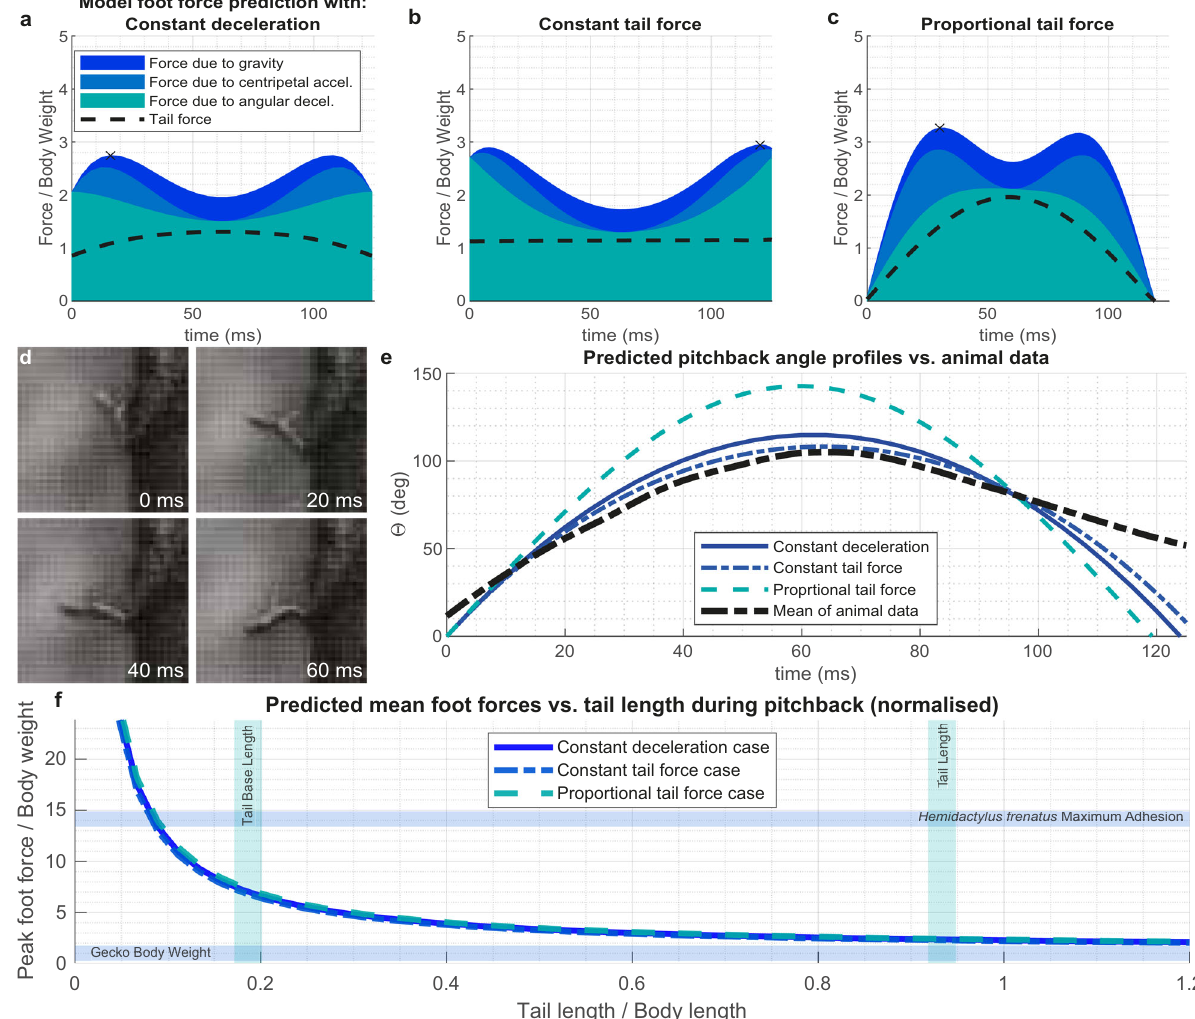
Fig. 4 Dynamic model predictions of fall arrest response. a – c Modeled foot force pro fi les during FAR, with constant angular deceleration, constant tail force, and a proportional tail force, respectively. d Gecko pitch-back image sequence. The initial angular velocity measured in the wild gecko was used as a boundary condition for the model solution. e Comparison of model and animal pitch-back time history. The constant angular acceleration case shows a similar maximum pitch-back angle and pitch-back duration as in the animal data. f Peak foot adhesion force required versus tail length, as predicted by the model. Shorter tails require higher foot adhesion forces, which could explain the lower success of tailless animals. By solving the model equations for a range of tail lengths, we observe the relationship between tail length and landing adhesive force. We found consistency between the three simple solution cases tried (see Fig. 4a – c) showing that a shortened tail results in greatly increased foot forces. On the plot, vertical lines indicate the tail length and the length of the tail base in caudotomized geckos. Horizontal lines indicate the mean body mass of the captured geckos and a measured adhesion force on glass from a closely related species of gecko, Hemidactylus frenatus